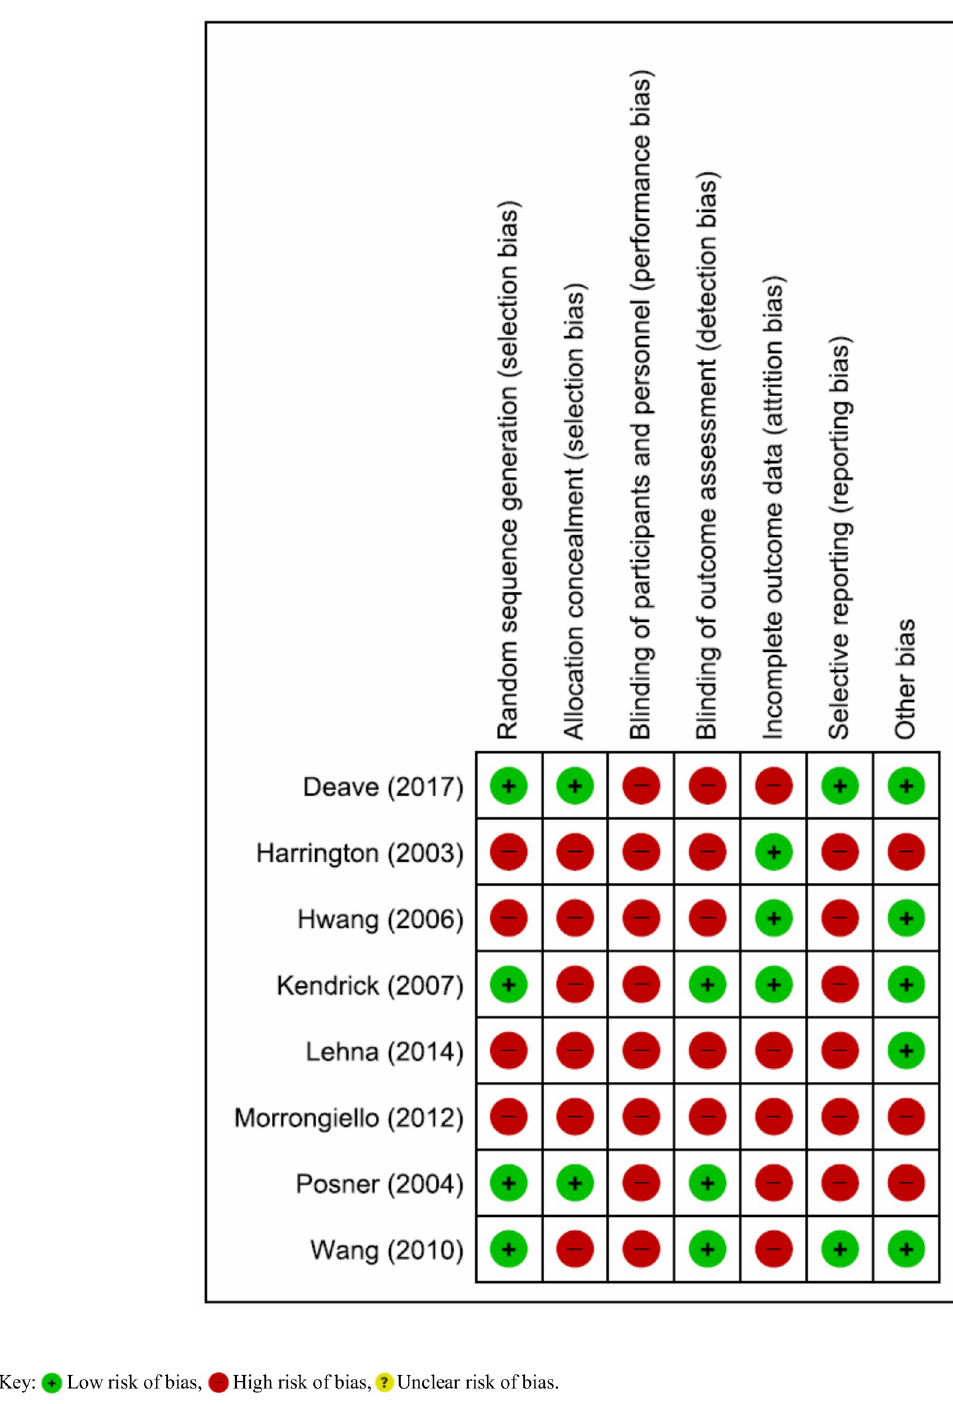
Fig 2. Risk of bias summary: Review authors’ judgements about each risk of bias item for each included